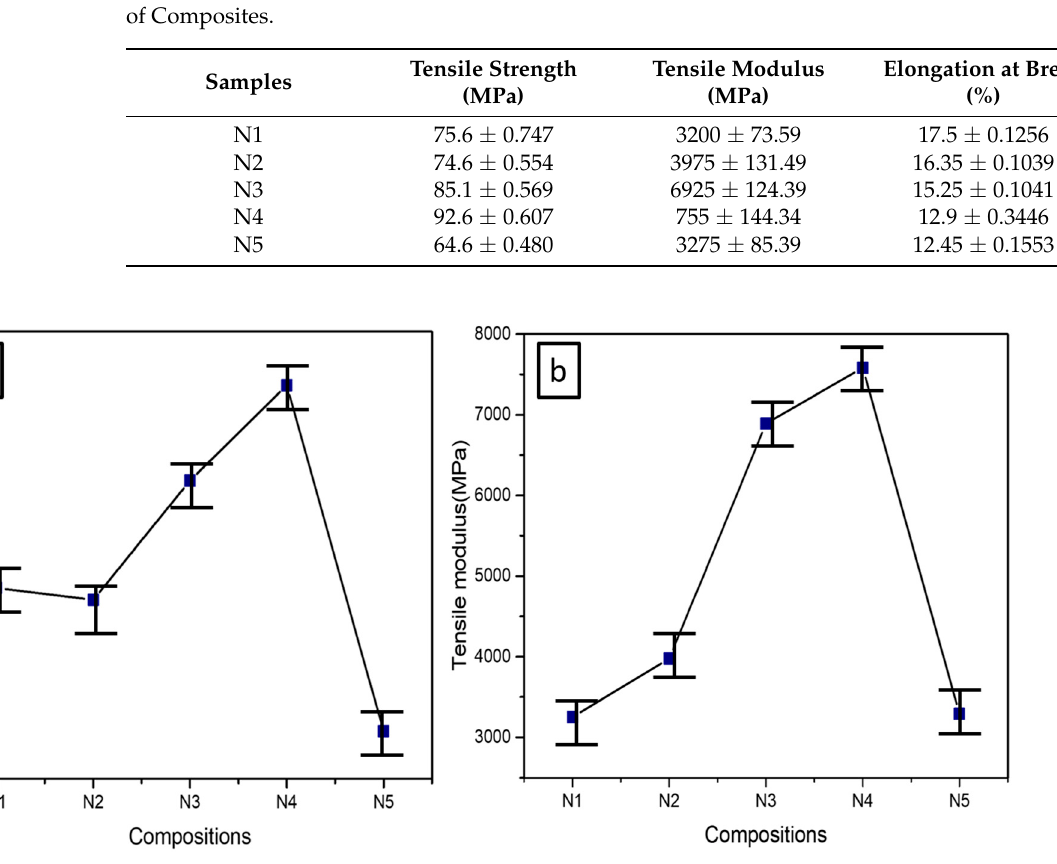
Figure 6. ( a ) Tensile strength (MPa) and ( b ) tensile modulus (MPa) of PLA-PBS-CNC nanocomposites at varying percentages of CNC.